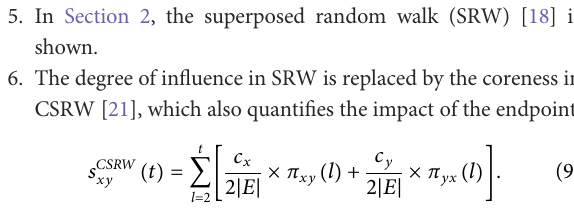
The values on DCHI enclosed in parentheses represent the equivalent ideal number of steps t .ThenumbersinparenthesesontheWDCHIrepresenttheappropriateidealstep size t and ideal inhibitory factor β . By modifying the coef fi cients, all of the current fi ndings demonstrate the best-case scenarios. The bold values represnet optimal